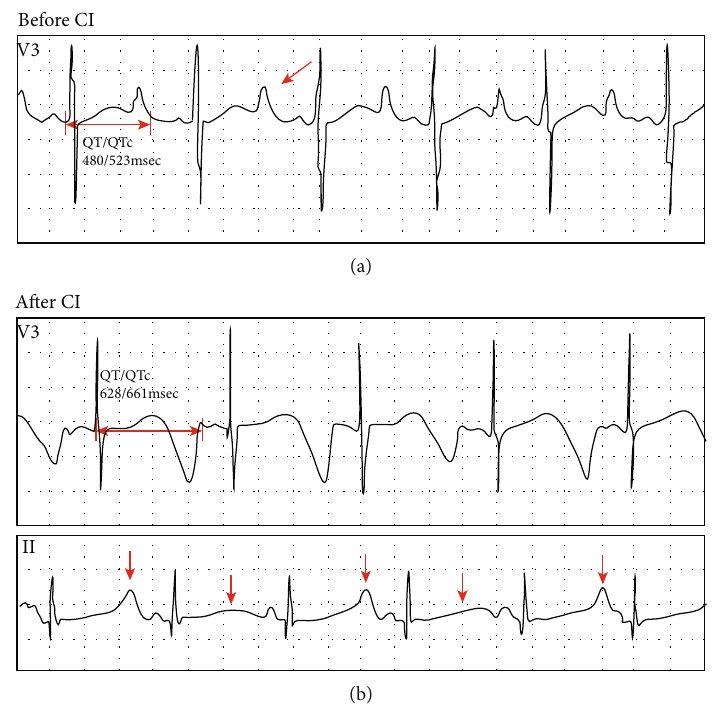
Figure 3: ECG detected in Proband 1-II-1. (a) The ECG waveforms before cochlear implantation (CI). Two-way arrow: QT/QTc interval. One-way arrow: dome and dart T wave. (b) The ECG waveforms after cochlear implantation (CI). Two-way arrow: QT/QTc interval. One-way arrows and arrowheads indicate T wave alternans (TWA).